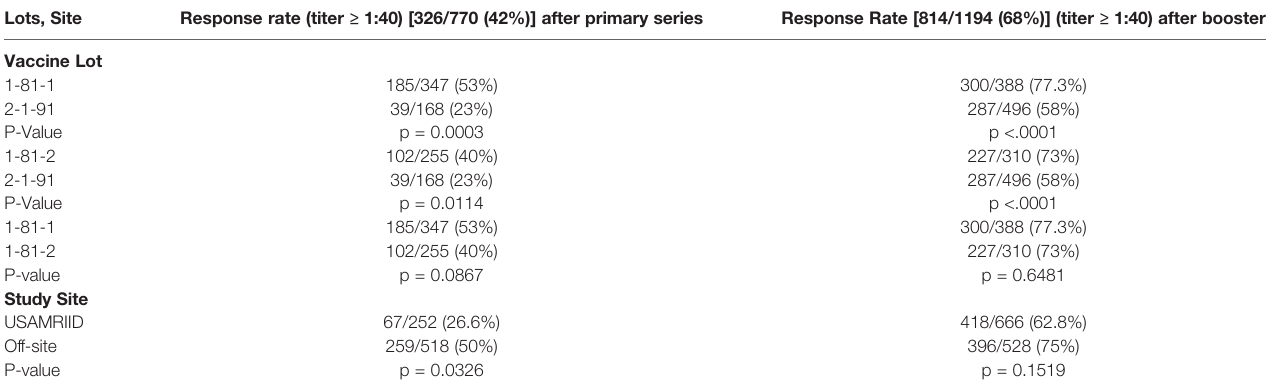
TABLE 4 | Differences in response rates after third primary dose and boosters in the FY87-8 study protocol by lot and study site. Lots, Site